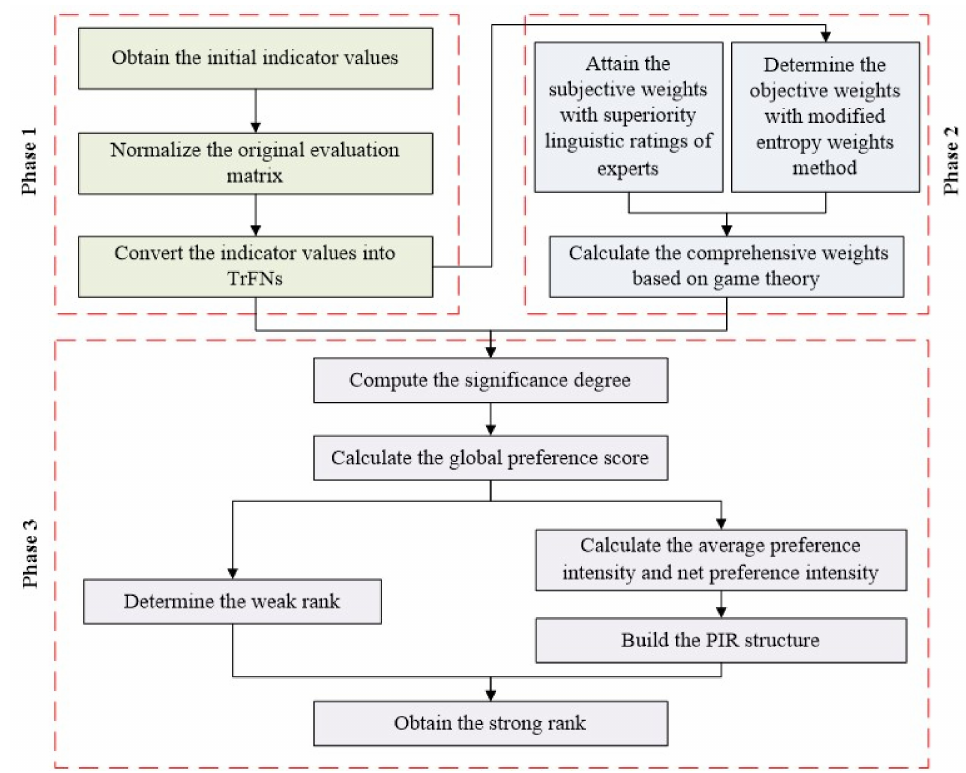
Figure 2. Framework of extended ORESTE method with